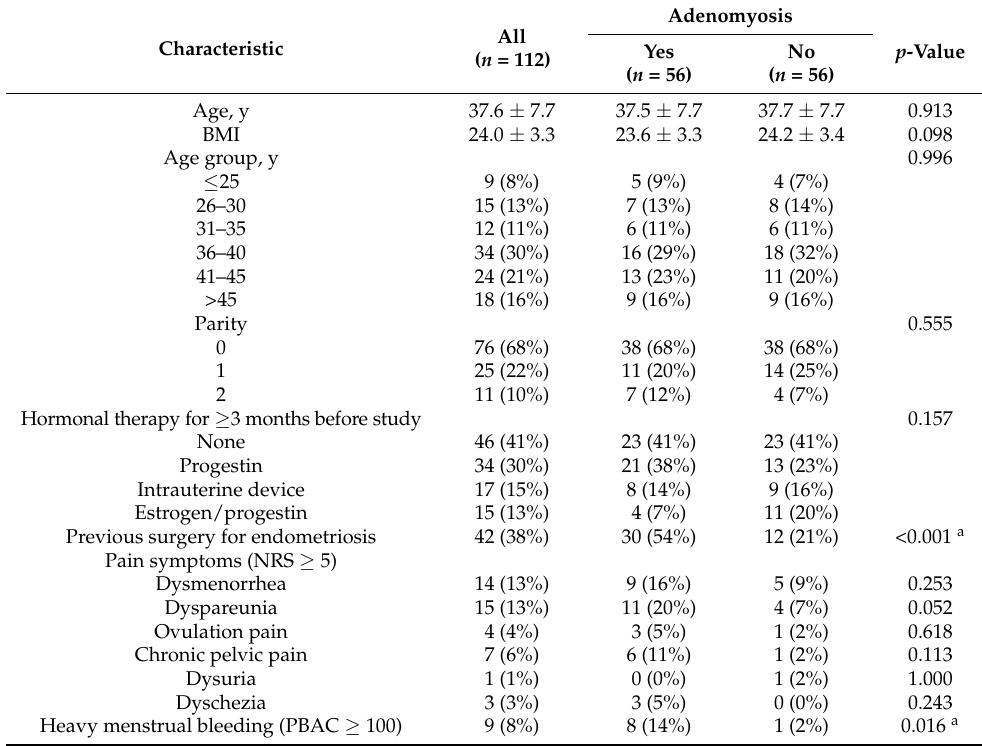
Table 1. Baseline characteristics of the entire study population and of the two study